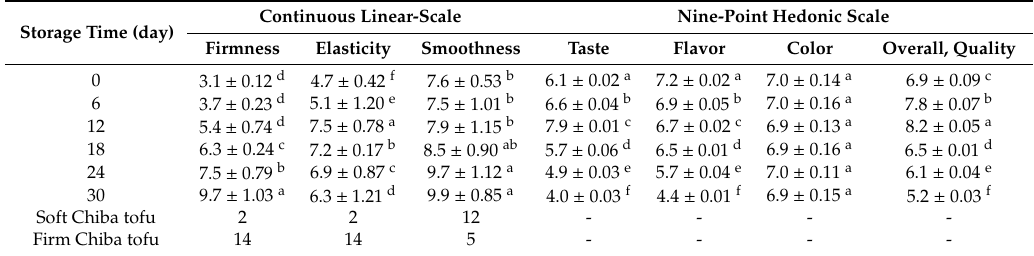
Table 4. Sensory evaluation of Chiba tofu with di ff erent storage